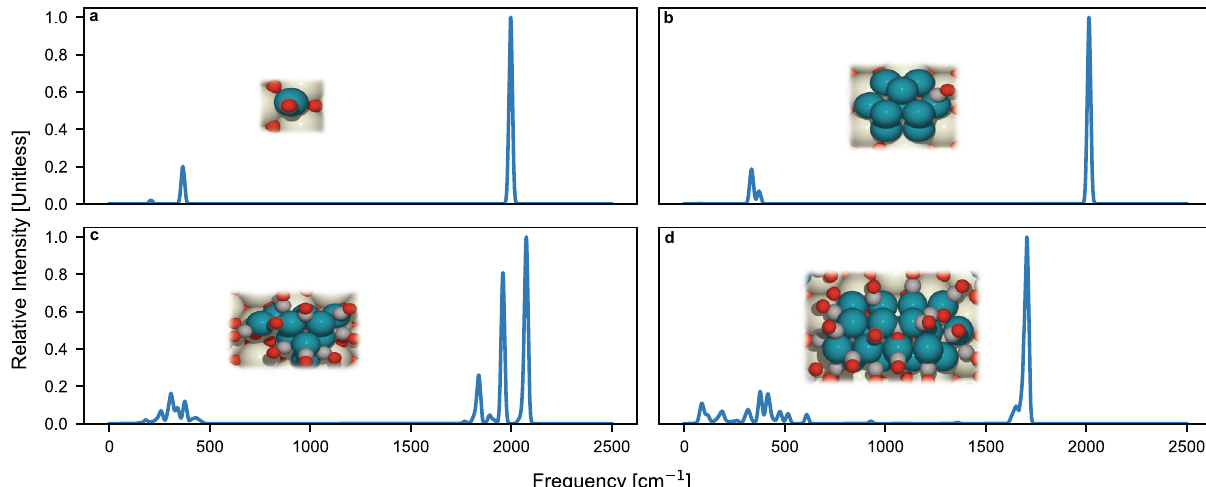
Fig. 4 | Primary spectra of CO on various sizes of Pd/CeO 2 and CO coverages fromDFT-computed frequencies and intensities. Linearscaling factorshave not been applied to these spectra. Differential coverage of CO on ( a ) Pd 1 /CeO 2 and ( b ) Pd 10 /CeO 2 . Saturated coverage of CO on ( c ) Pd 10 /CeO 2 and ( d ) Pd 20 /CeO 2 . Differ- ential coverage refers to a single CO molecular adsorbed on the most stable